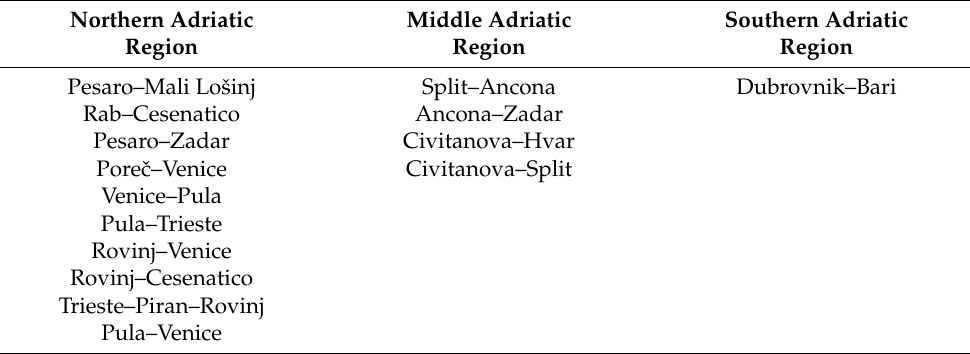
Table 2. Distribution of maritime transportation lines in the defined Adriatic